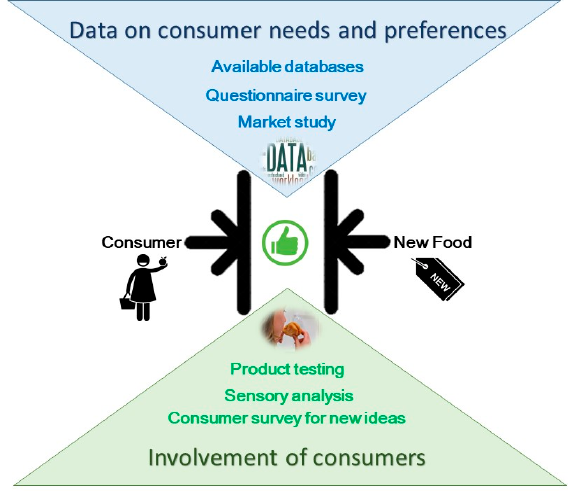
Figure 2. Fitting of the new food product with target consumers (author’s own work).